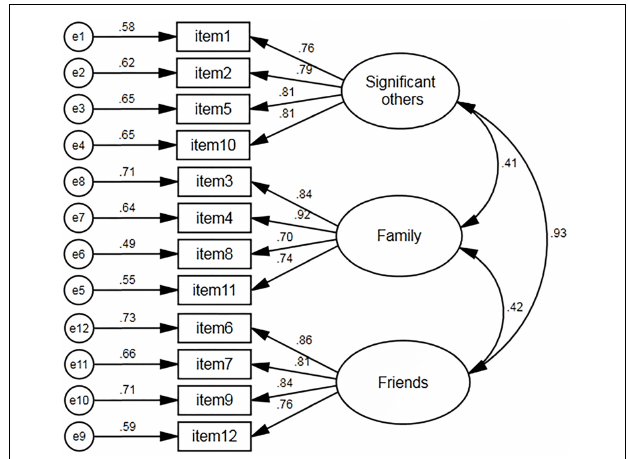
FIGURE 1 | The structure model of Chinese